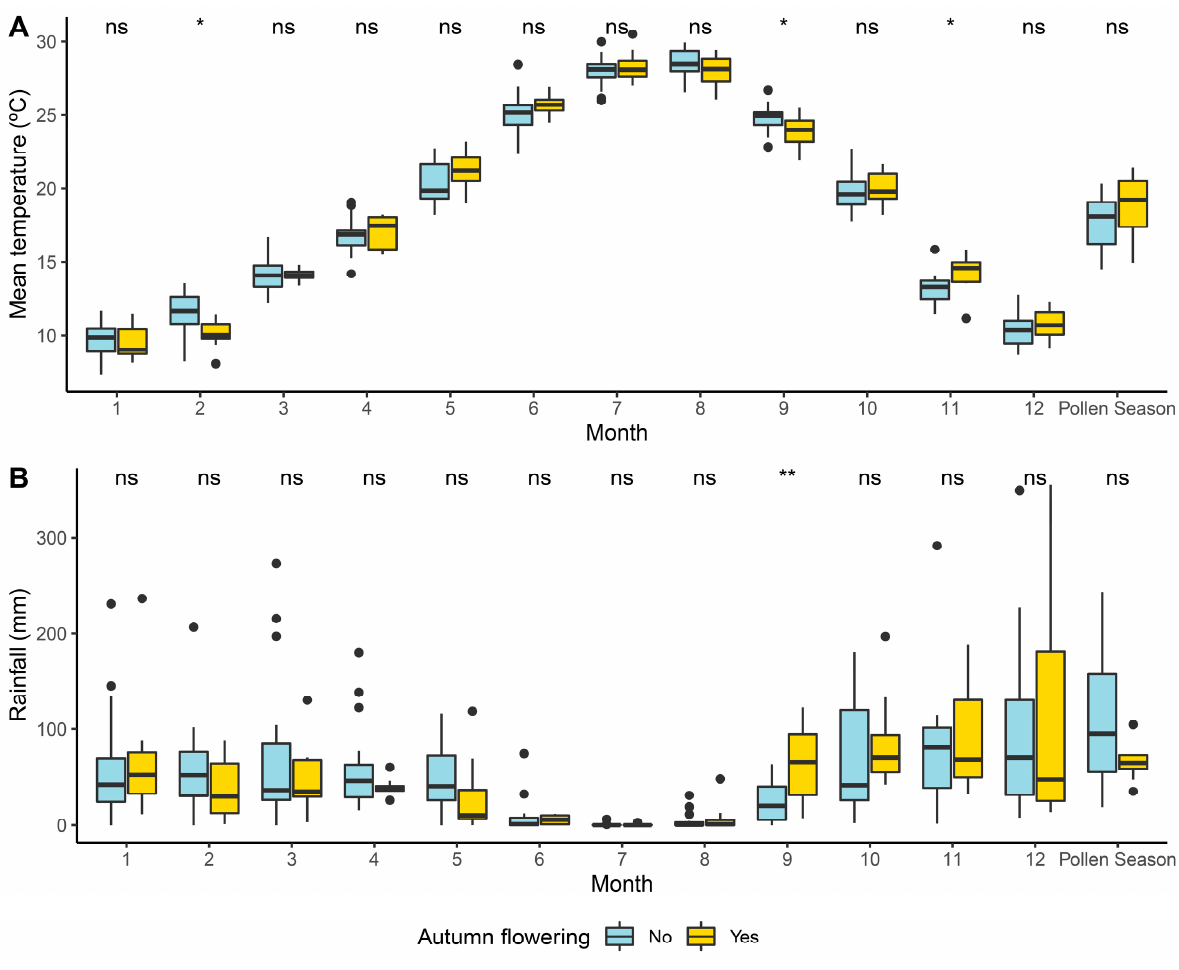
Figure 3. Box plot showing the distribution of monthly average (and during pollen season) of daily mean temperature ( A ) and monthly sum of rainfall ( B ) of the years in which an autumn flowering was observed: 1999, 2002, 2006, 2009, 2012, 2014, and 2015. Autumn pollen integral > 100 pollen grains * day/m 3 , yellow) and years without autumn flowering (blue). Mann–Whitney–Wilcoxon test significance levels: non-significant ( ns ), significant at p -value: 0.05 *, 0.01 ** and 0.001 ***.